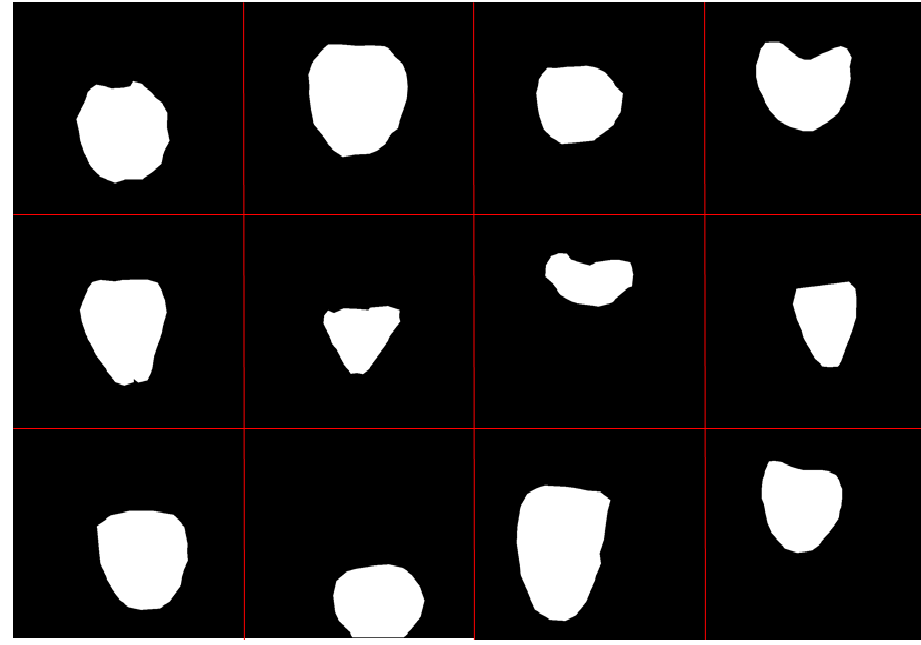
Figure 9. Samples from the mask set corresponding to the tongue images in Figure